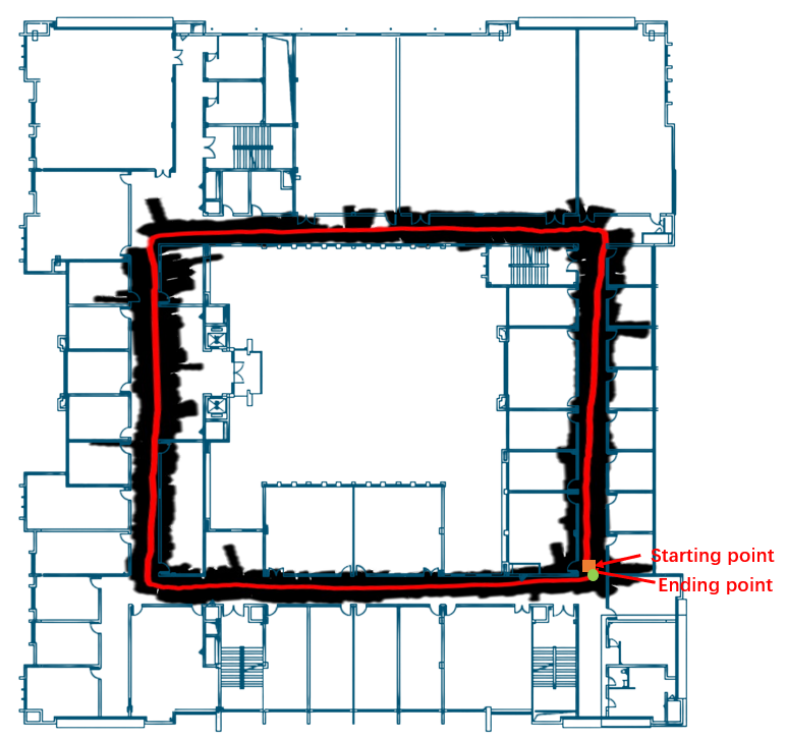
Figure 13. Plotting the 2D mapping result of Scenario 1; the red line represents the individual’s position, and the black area represents the mapping results.